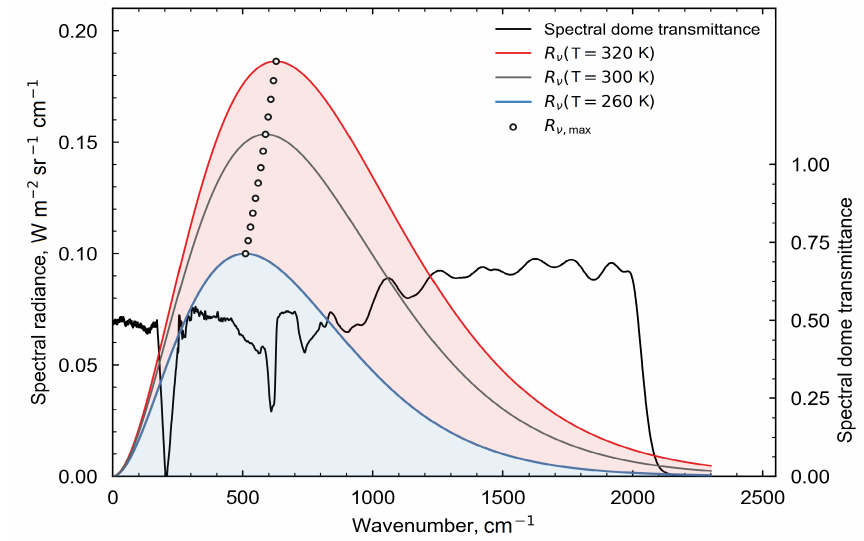
Figure 14. Spectral dome transmittance for a Kipp and Zonen pyrgeometer overlaid with Planckian spectral radiance curves at T = 260 K, 300 K, and 320 K. This illustrates the different relative effects of the pyrgeometer spectral dome transmittance on Planckian radiances at different